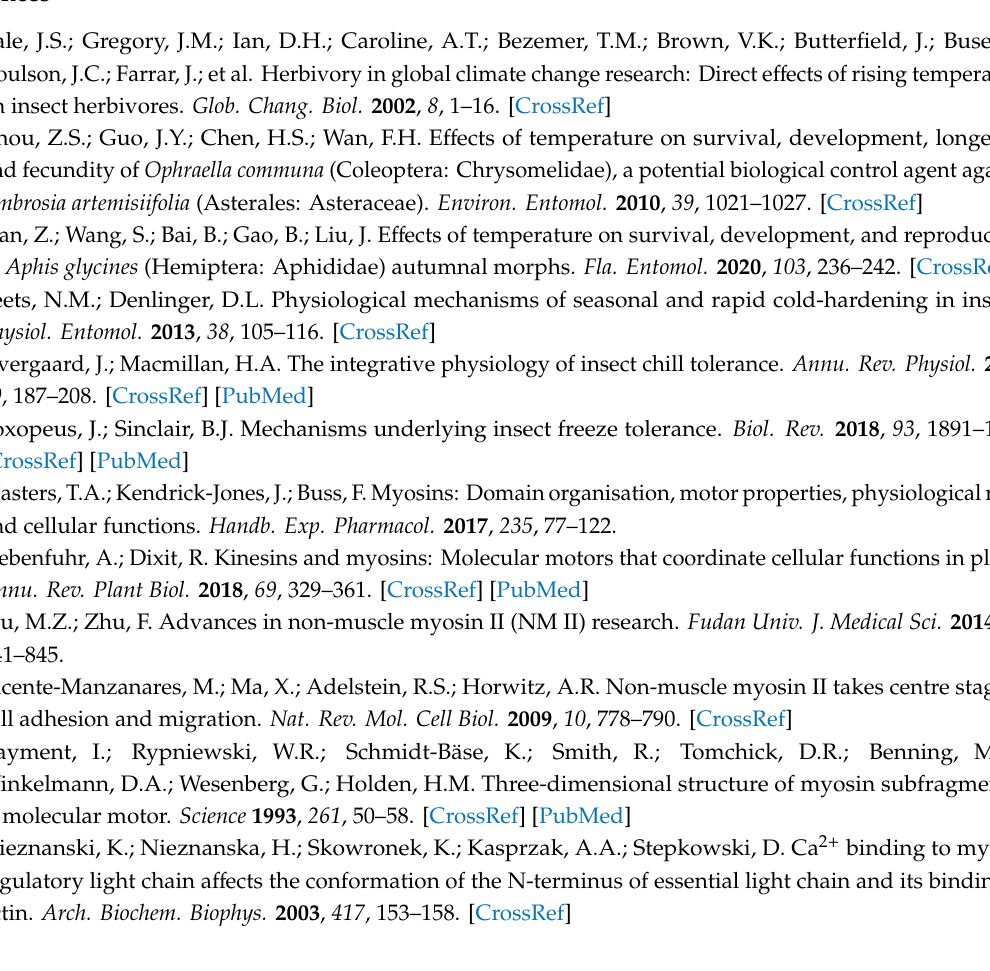
Table S1: Transcriptome data of MRLC-sqh for design of specific